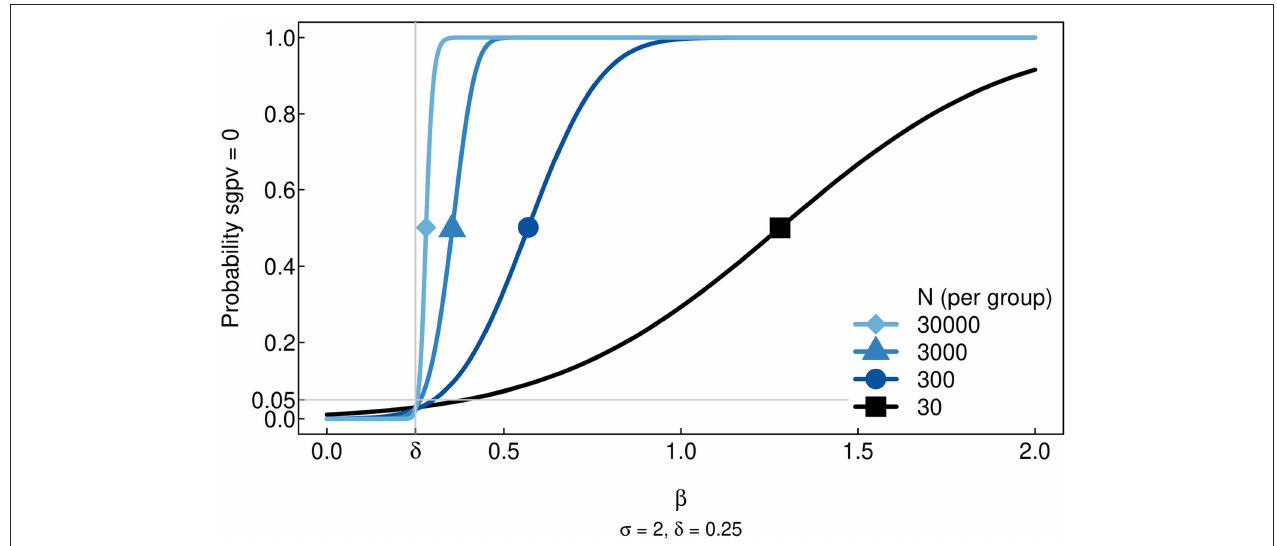
FIGURE 5 | Simulation results showing the Type I and Type II Errors rates for the SGPV as the sample size (N) increases. Within the null region (i.e., all values of beta less than delta), the probability that the SGPV = 0 gets increasingly small as N gets larger. In contrast, for beta values beyond the null region, the probability that the SGPV = 0 goes to 1 as N gets larger. At delta, the boundary of the null region, the probability that SGPV = 0 is controlled at α = 0.05 or less. Hence, the Type I Error rate goes to 0 as N increases. For non-zero values of beta within the null region, the Type II Error rate goes to 1.